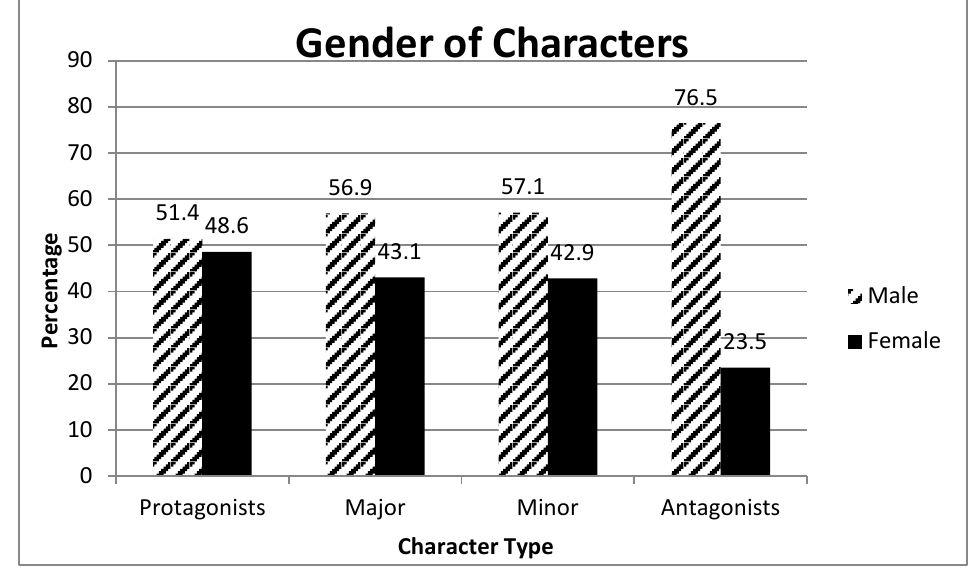
The gender of chracters divided by chracter type (protagonist, antagonist, major, and minor chracters). Males and females have nearly equal representation with the exception of